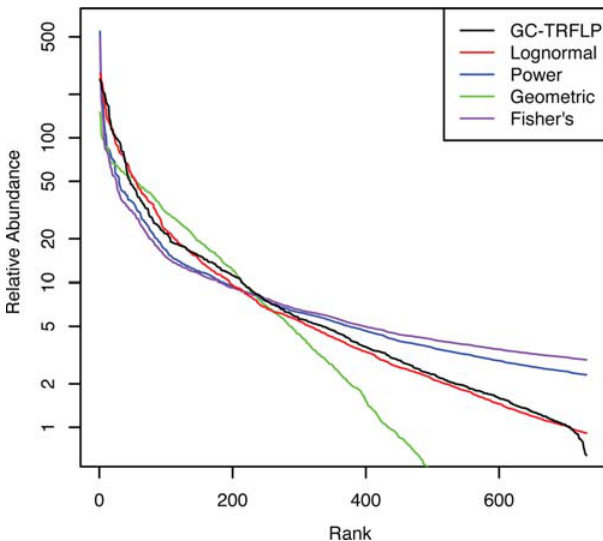
Figure 5. GC-TRFLP data for soil and the distributions that provided the best fit to this data. Goodness-of-fit measurements are given in Table 2.